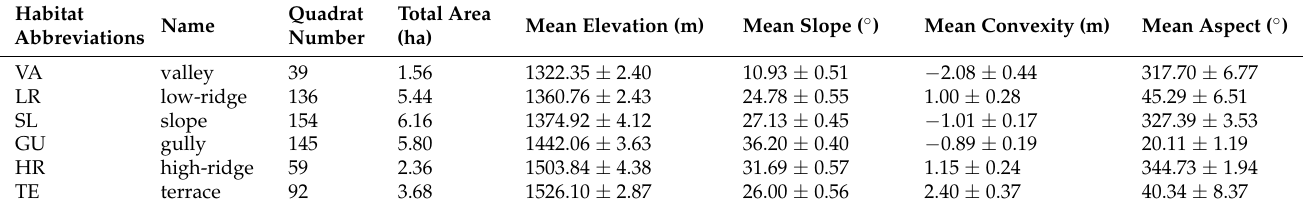
Table 1. Habitat classification.